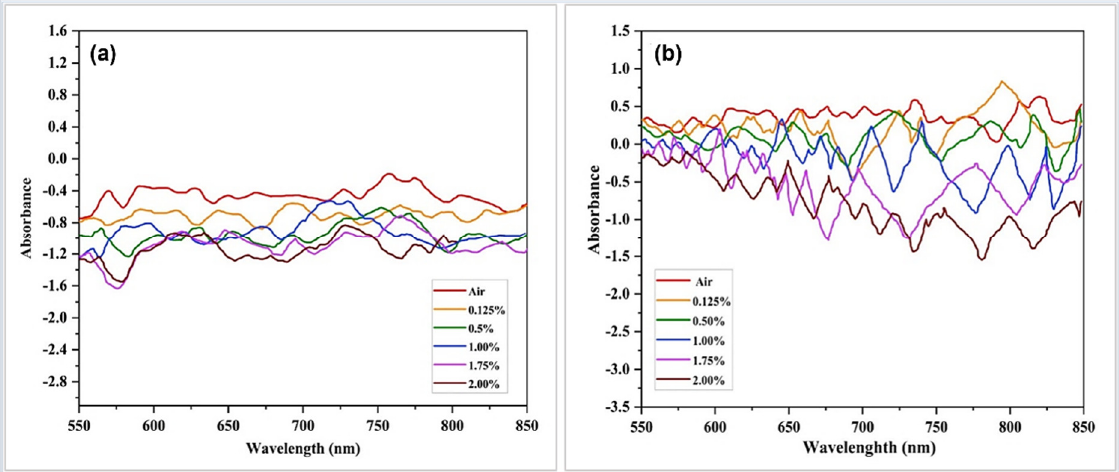
Figure 15. Absorbance versus optical wavelength ( a ) Pd/GO and ( b ) GO-coated optical fiber-based sensor towards synthetic air and 2.00% H 2 at 100 °C.